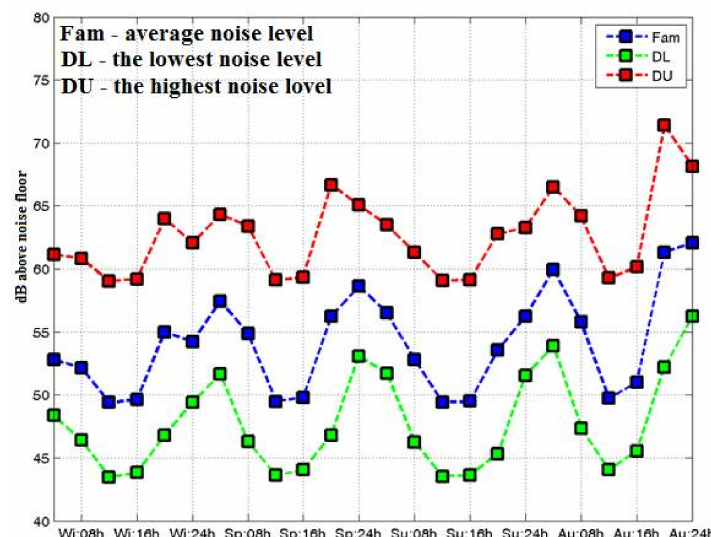
Figure A1. HF noise level in Gulf of Guinea.